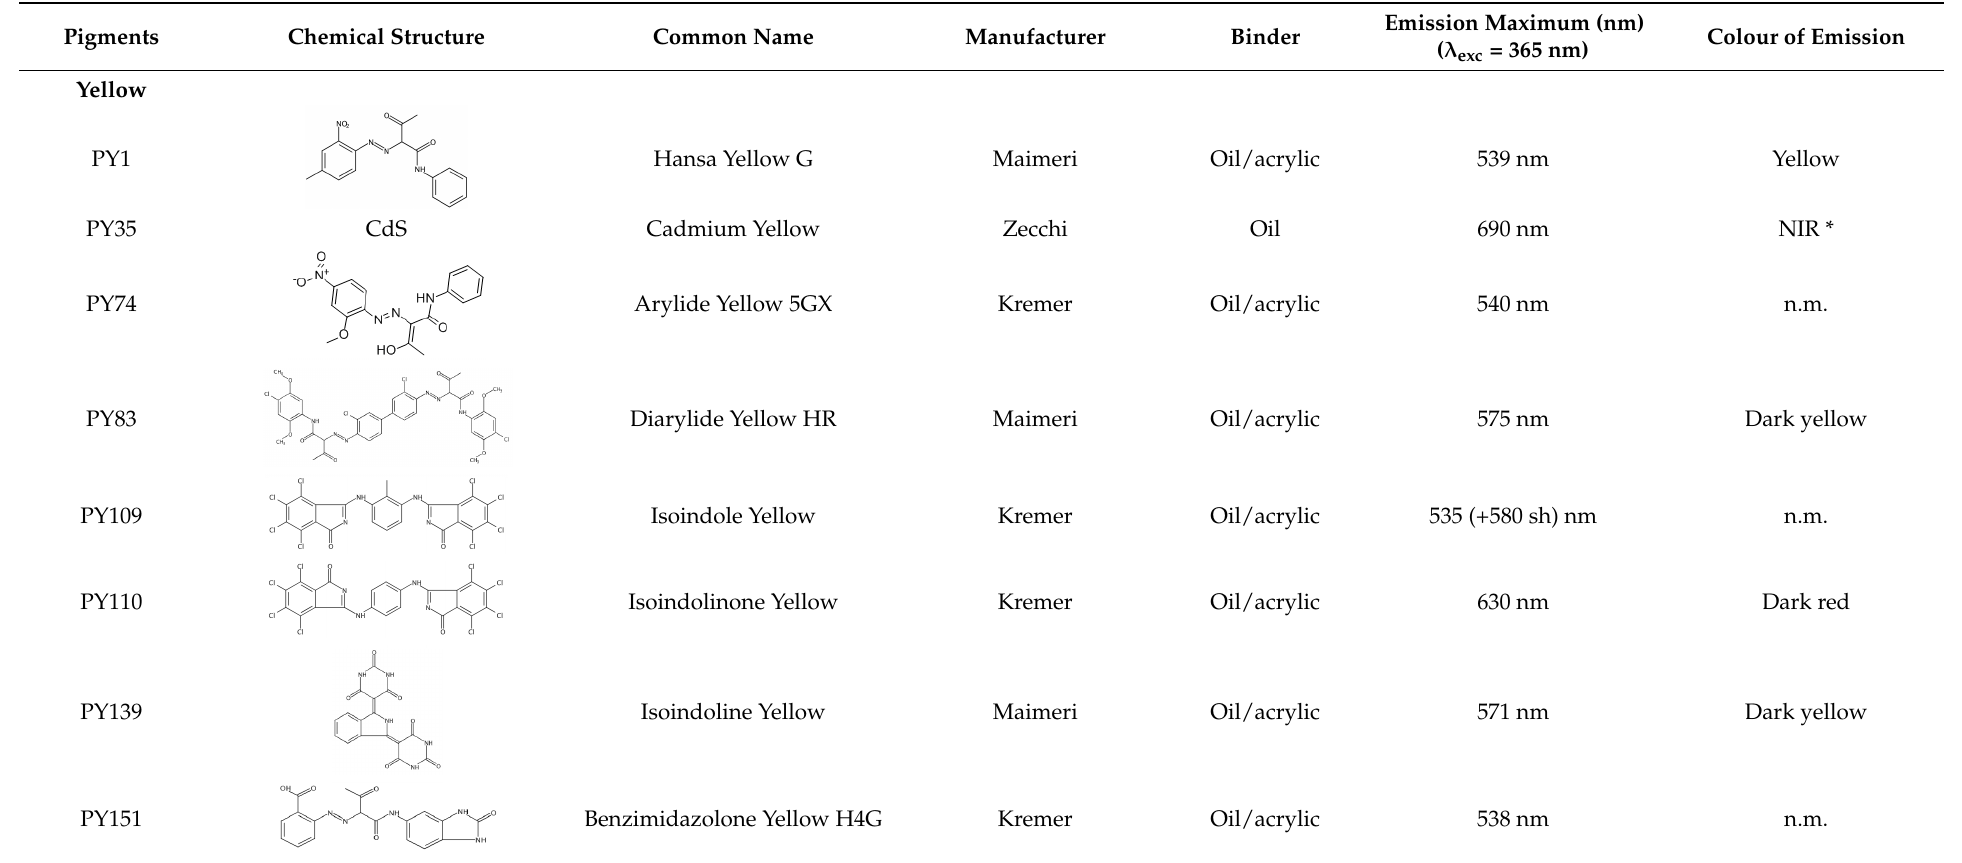
Table 1. Chemical structures, wavelength of the emission maxima measured by spectrofluorimetry and the corresponding colour of emission observed in the RGB images for synthetic organic pigments examined in the present work when excited with 365 nm radiation.